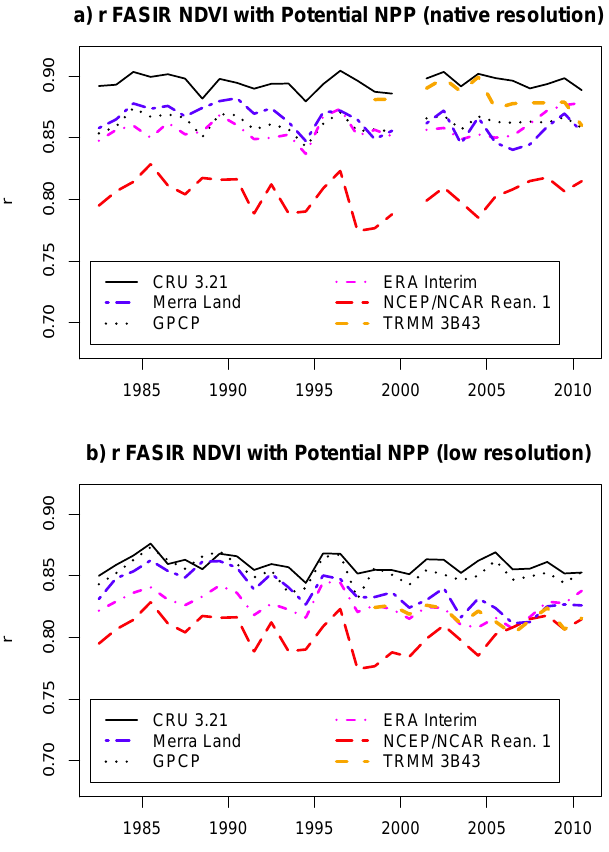
Figure 3. Spatial correlation for 1982–2010 between mean annual FASIR NDVI and potential annual NPP for six precipitation prod- ucts. Correlations are calculated for the entire land surface between 45 ◦ S and 45 ◦ N and indicate spatial agreement between rainfall pat- terns and the vegetation index. Highest correlations are found for CRU NPP, lowest for MERRA (not MERRA Land) NPP (0 . 611 < r < 0 . 681; not shown). (a) Correlations at native resolution of pre- cipitation data. (b) Correlations with data scaled to NCEP/NCAR resolution (1 . 875 ◦ × 1 . 875 ◦